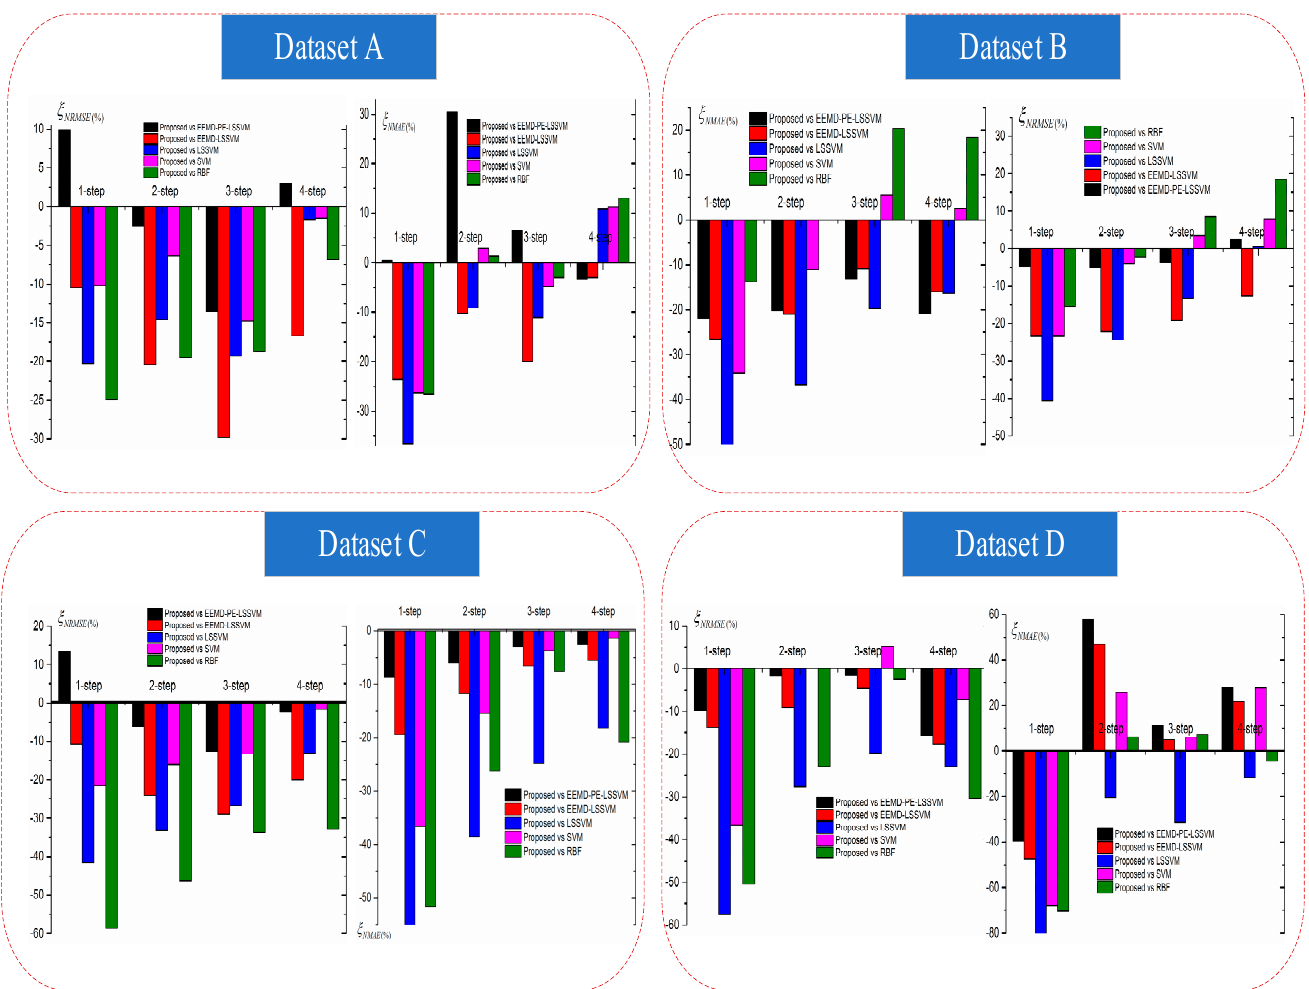
Figure 13. Histograms of NRMSE and NMAE for all models using Datasets A, B, C, and D, with (1–4)-step-ahead.